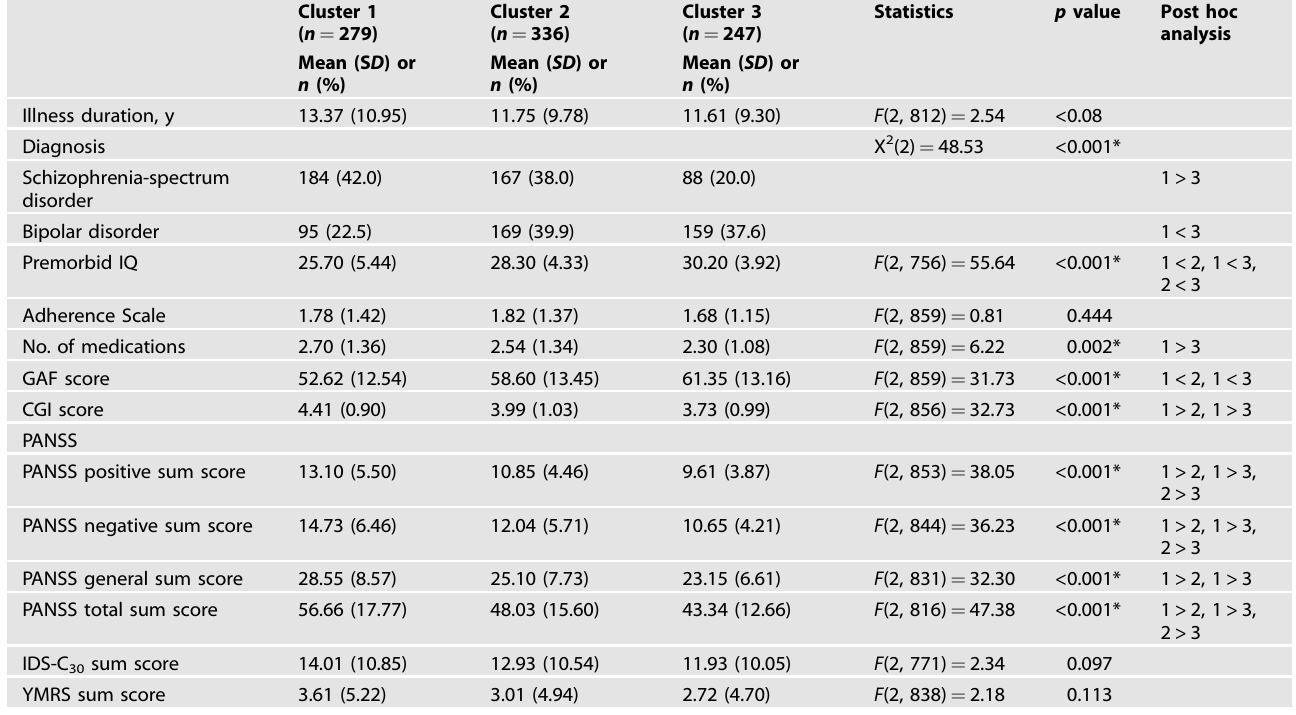
Table 5. Descriptive analyses of the three